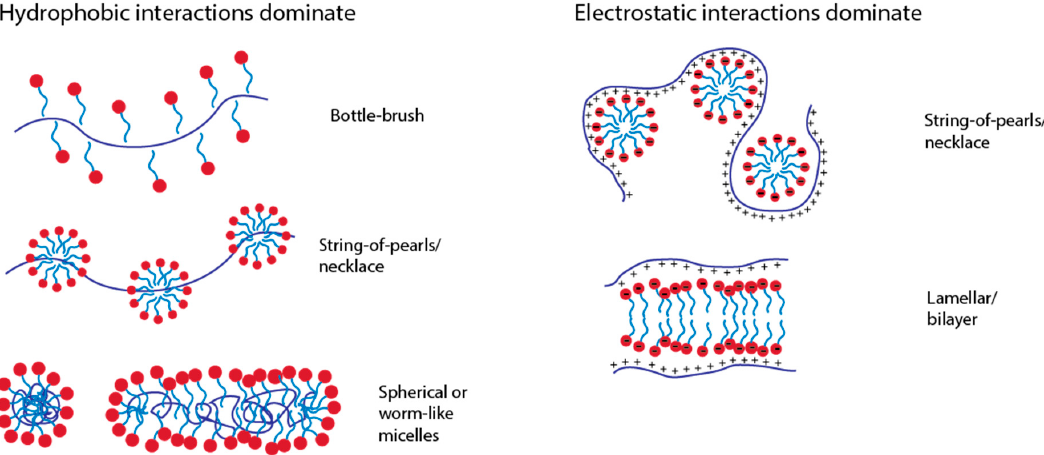
Figure 7. Typical micellar or micelle-like structures formed with polyelectrolytes.